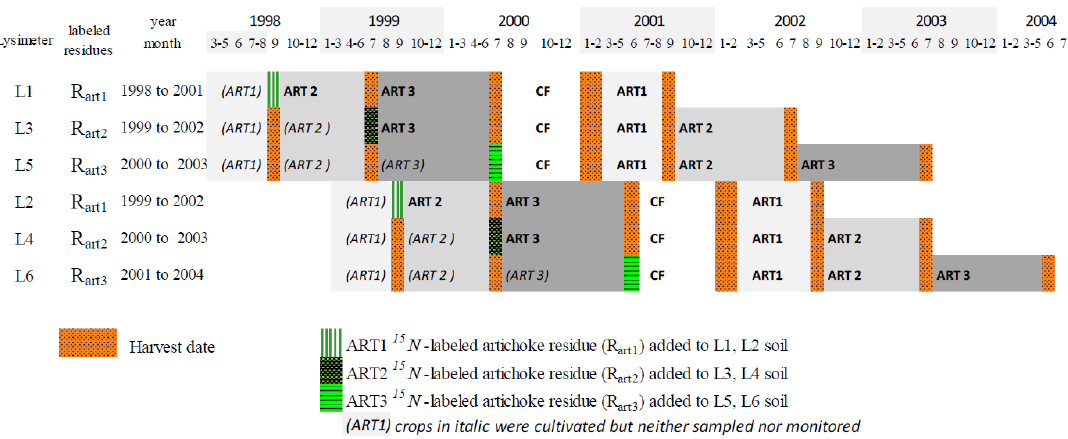
Figure 1. Crop rotations in six lysimeters (L1 to L6) and 15 N -labeled artichoke (ART) residues applied to soil (R ART1 , R ART2 and R ART3 ) in ART–cauliflower (CF) rotations.